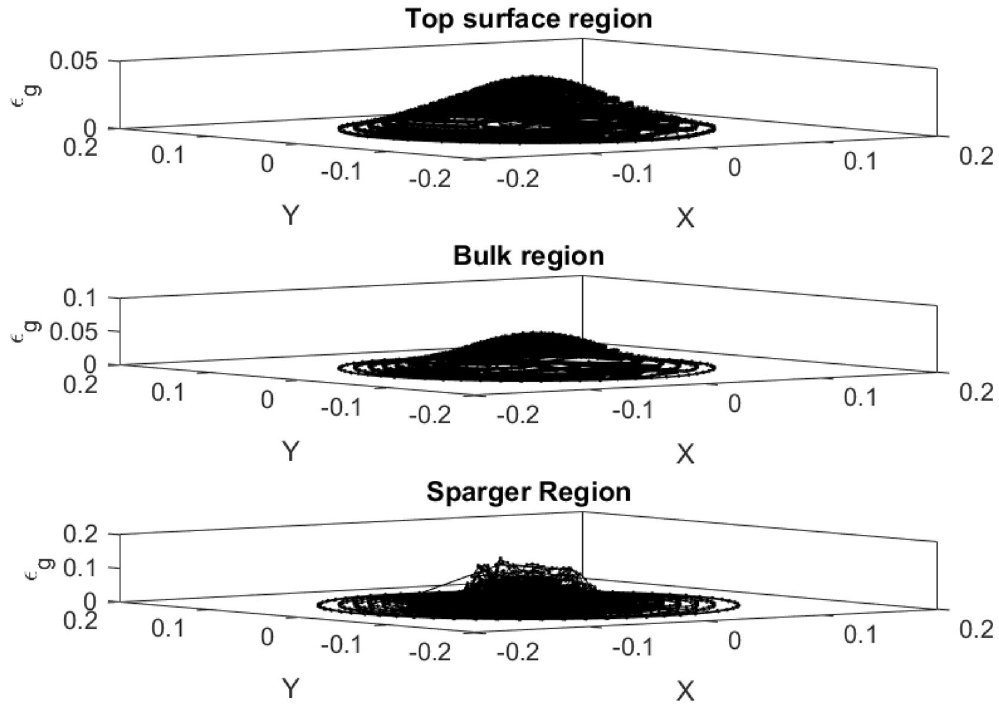
Figure 5. Amount of gas hold-up at X and Y computing points for the surface, bulk region and sparger region of the reactor.